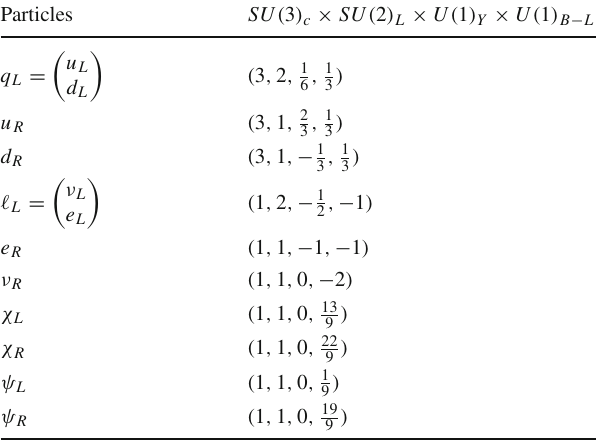
Table 1 Fermion content of the model Particles